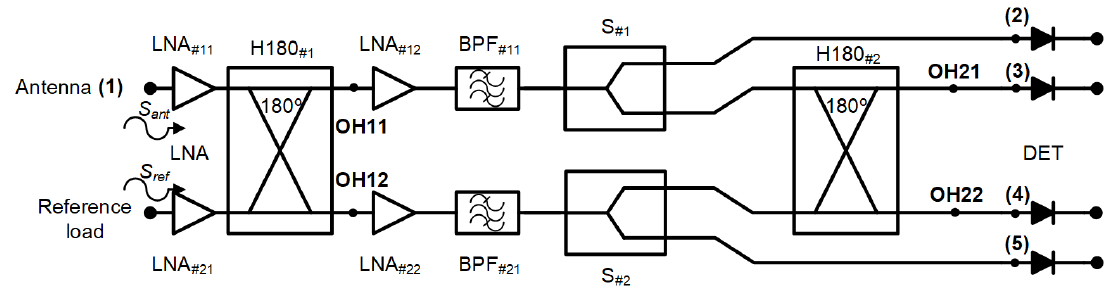
Figure 2. The new pseudo-correlation schematic using 180 ◦ hybrid couplers to correlate the signals and Wilkinson power